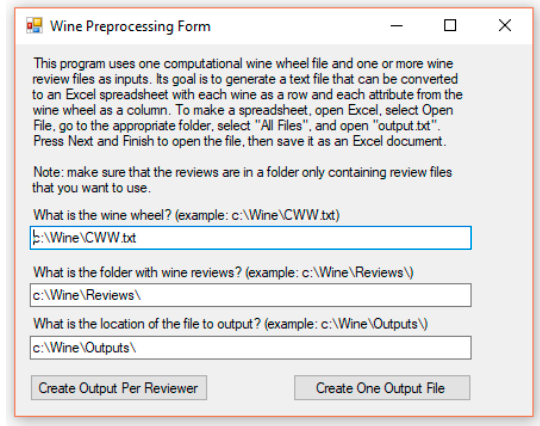
Figure 2. Wine Preprocessing Forms.